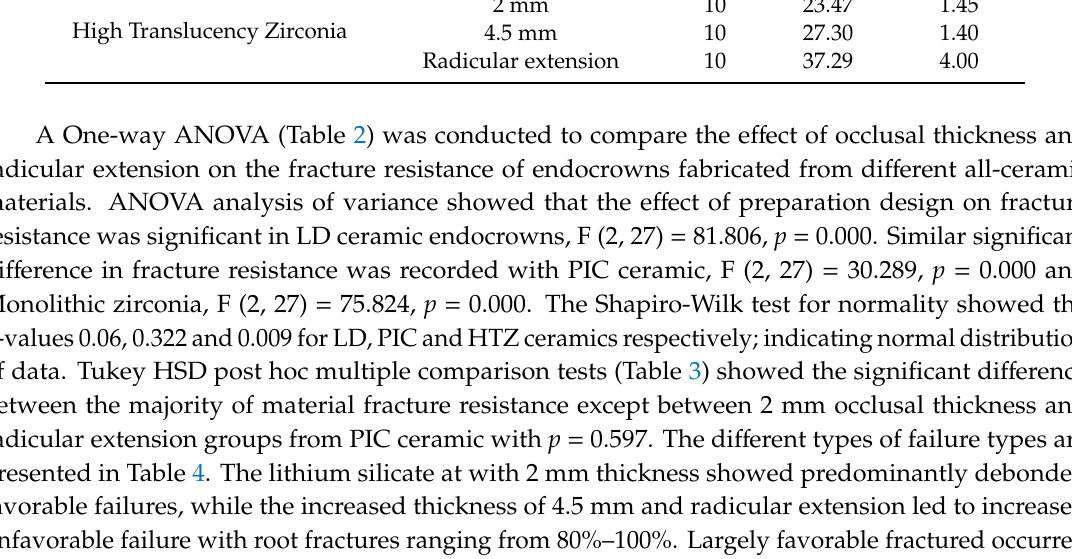
Figure 3. Fractured teeth specimens to evaluate the failure mode.